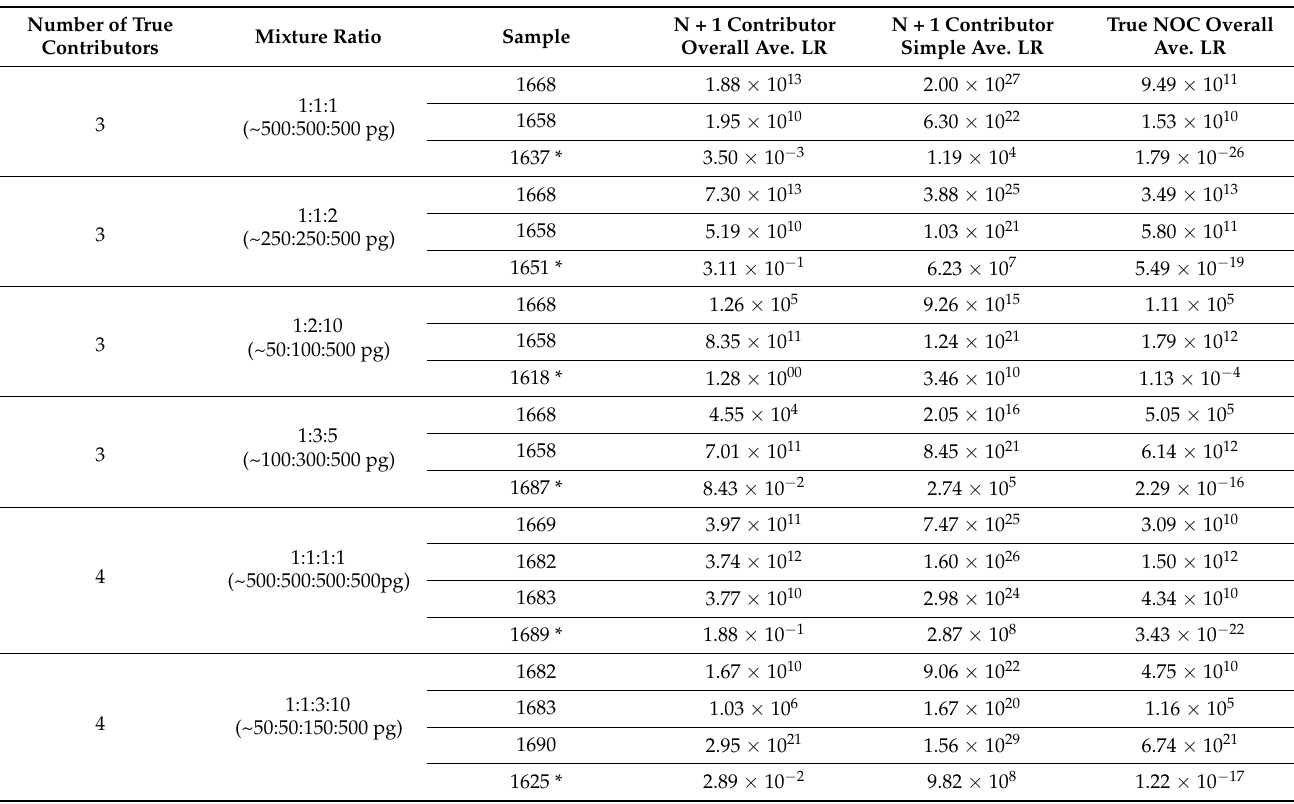
Table 8. Summary of the average (N = 5) calculated LR results of the N + 1 NOC tests, including a true non-contributor (*) for each of the component samples in its respective mixture. The contributors in each mixture are listed in the order of the position and ratio that they occupied in the mixture. The four-person mixtures altered the sample order, depending on the ratio being tested, for additional variability. All data shown are from undiluted samples, with the approximate quantities of DNA template in each mixture indicated. Overall (sub-sub-source) LRs consider the position of the individual contributor in the mixture, while simple (sub-source) LRs do not. The average overall (sub-sub-source) LR values for each mixture contributor calculated with the true NOC is included for